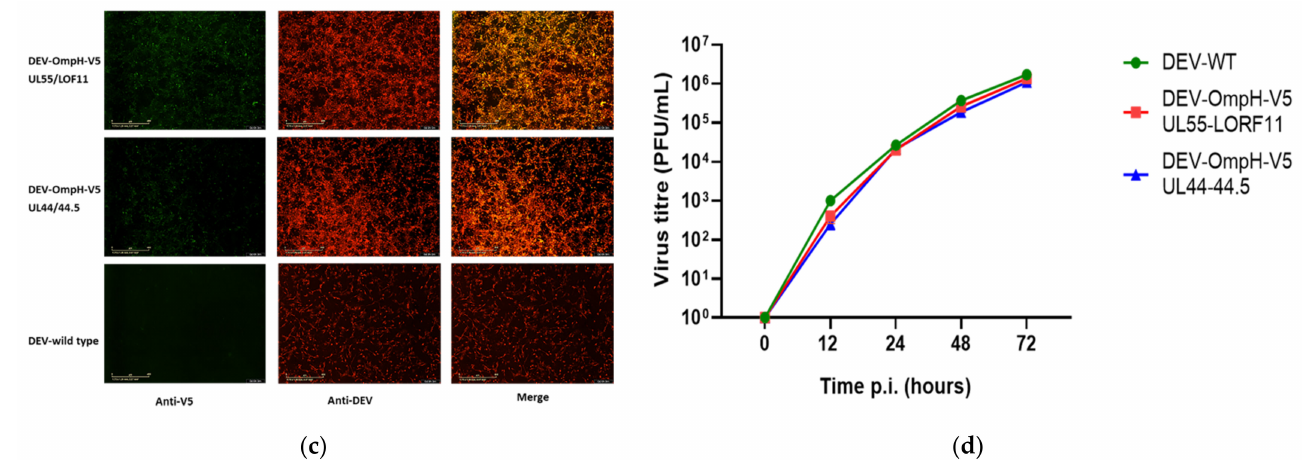
Figure 6. Characterization of each recombinant DEV-OmpH-V5 infected CEF cells. ( a ) Lower panel shows the expression of OmpH protein was analyzed by Western blot using anti-OmpH polyclonal antibody. The positive OmpH expression of CEF cell lysate infected with rDEV-Omp-V5 of UL55- LORF11 (lane 3 and 4) and rDEV-Omp-V5 of UL44-44.5 (lane 5 and 6) were duplicate loaded into each lean. While CEF cells lysate infected with DEV-WT was loaded into lane 2 for negative control. The recombinant OmpH protein was loaded in last lane for positive control. The molecular weight was indicated in first lane. Upper panel shows antibody specific to DEV as a DEV loading control. ( b ) This panel shows the confirmation the successful of V5 expression by indirect immunofluorescence assay (IFA) with anti-V5 monoclonal antibody (green) sequentially strained with DEV-infected mouse serum (red) for detection of DEV infected-cells. The region of merged images was taken by Incucyte machine. ( c ) Upper panels display plaque morphology of DEV wild type, DEV-OmpH-V5 of UL55- LORF11 and DEV-OmpH-V5 of 44-44.5. Lower graph shows the plaque diameters of CEF cells infected with recombinant DEVs and DEV wild type were measured at 6 days post infection. ( d ) The multi-step growth kinetic curve of recombinant DEVs and DEV wild type infected CEF cells at MOI 0.01. Supernatants were collected and viral titers were determined at the indicated time points post-inoculation by plaque assay. ( p <